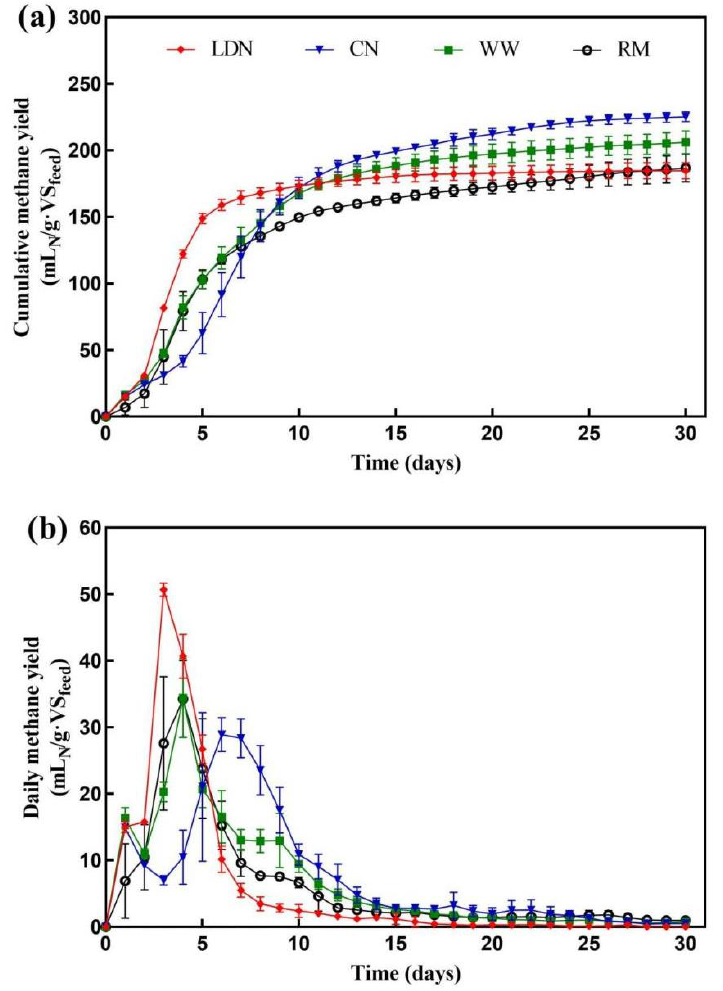
Figure 3. Effect of different neutralization treatments on the ( a ) cumulative methane yield; and ( b ) daily methane yield during 30 days thermophilic L-AD of lime-treated corn stover. Data are shown as mean ± SD, n = 3.